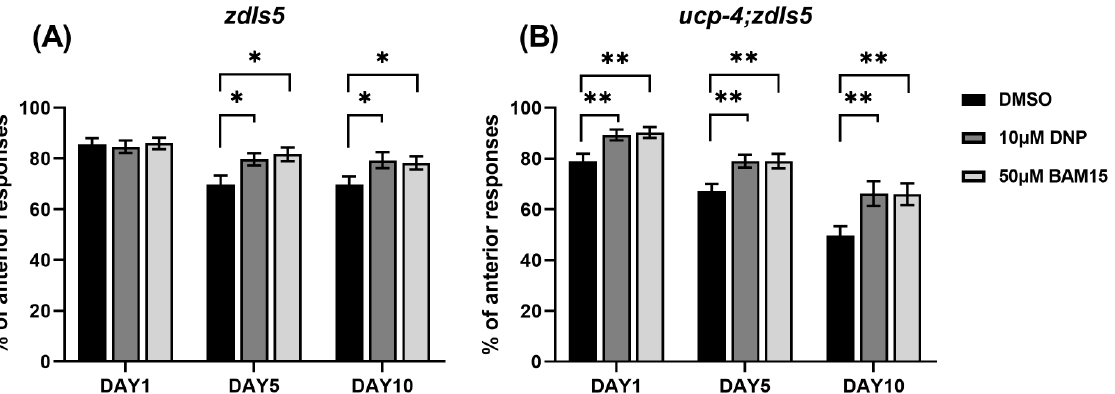
Figure 2. BAM15 retains touch responses in aged C. elegans . ( A , B ) Anterior touch responses are presented as a percentage of the total responses in zdIs5 and ucp-4 ; zdIs5 worms treated with 10 µM DNP and 50 µM BAM15 on Days 1, 5, and 10. Data are represented as means of three independent experiments. Error bars represent the SEM. n = 30 worms per treatment in each experiment. * p < 0.05, ** p < 0.01. Unpaired Student’s t -tests were performed to compare the DMSO control and treatments.